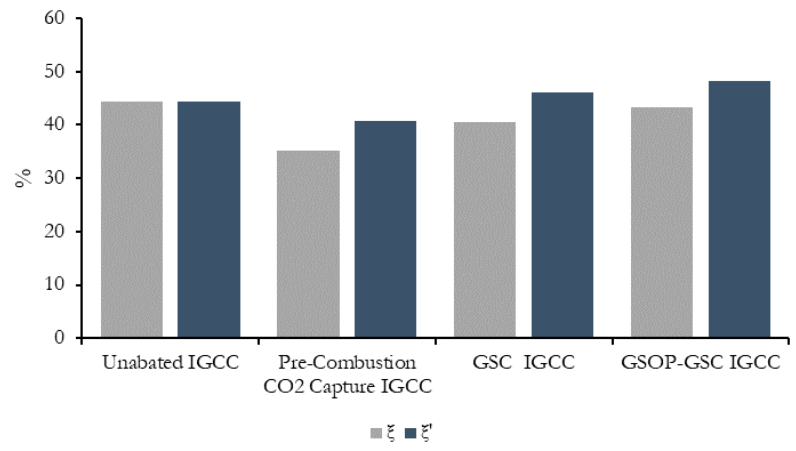
Figure 10. Exergy e ffi ciencies of the di ff erent power plants. Figure 10. Exergy efficiencies of the different power plants. Figure 10. Exergy efficiencies of the different power plants.